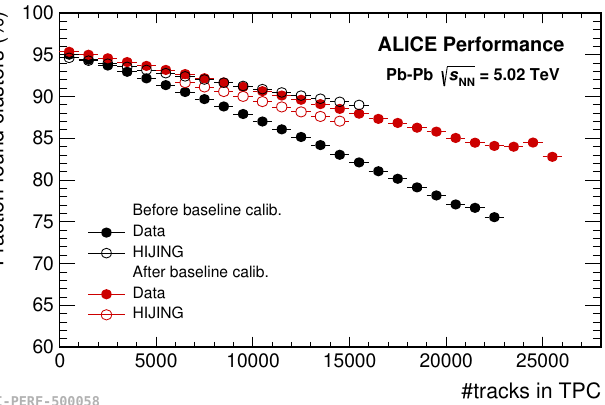
Figure 8. (Color online) Cluster finding efficiency as a function of track multiplicity before (black markers) and after (red markers) the baseline calibrations applied in the data and full simulation of the HIJING [15] event generator employing a GEANT4 implementation of the ALICE detector